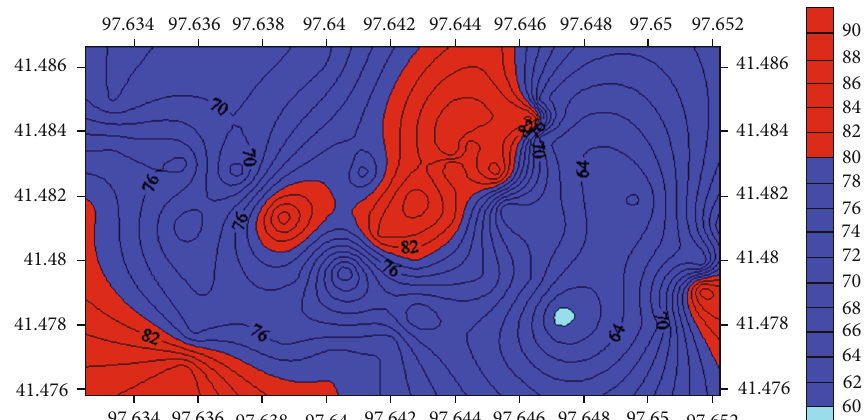
Figure 9: The contour map of F